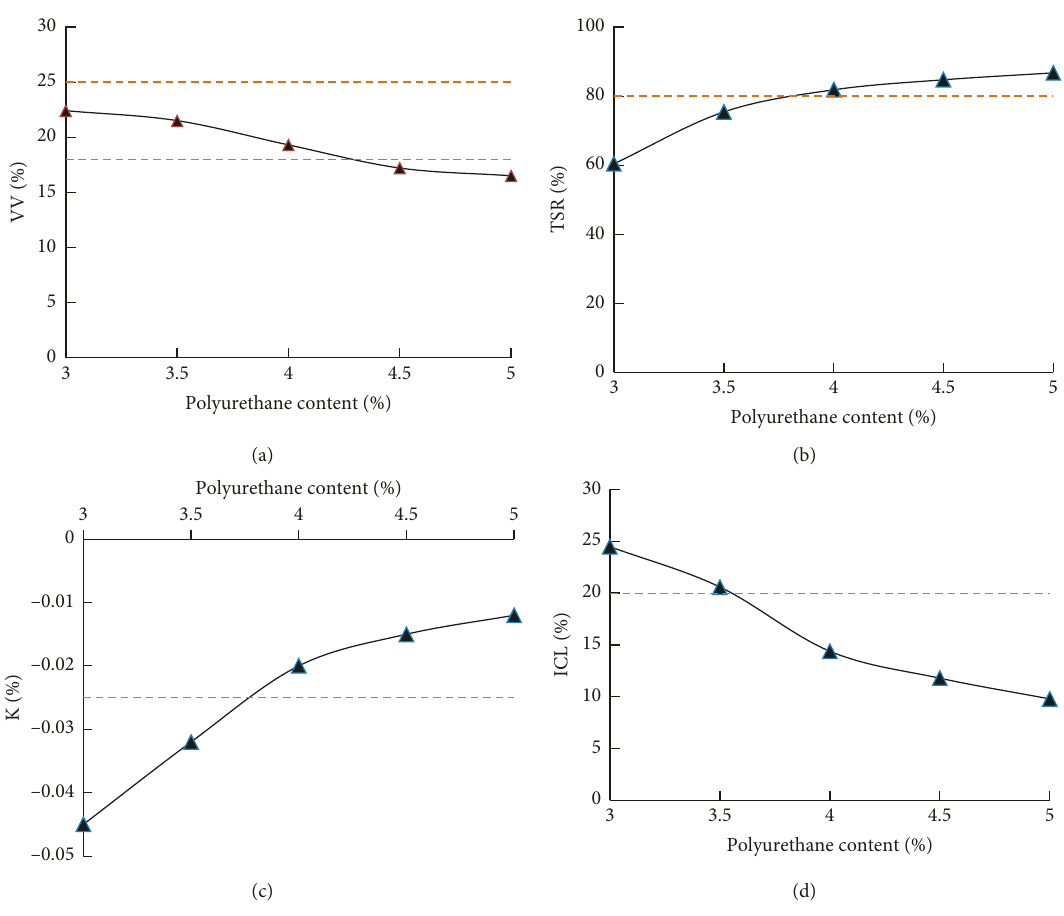
Figure 11: Key index value of the PU mixtures with a different PU dosage: (a) VV; (b) TSR; (c) K ; (d) ICL. Table 4: The basic properties of the three mixtures.